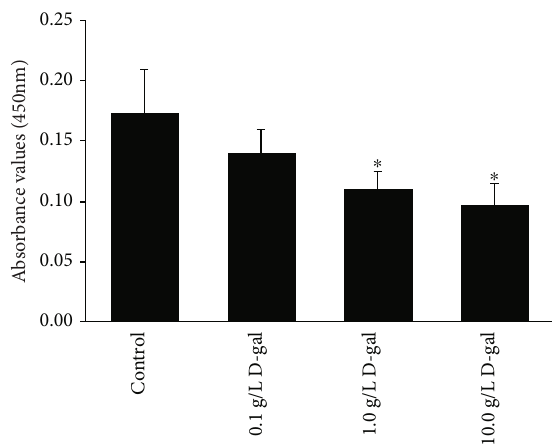
Figure 2: E ff ect of D-gal on J774A.1 proliferation. The CCK8 result showed that the absorbance value signi fi cantly decreased in 1.0 and 10.0g/L D-gal groups compared with the control group ( ∗ P < 0 : 05 , n = 3